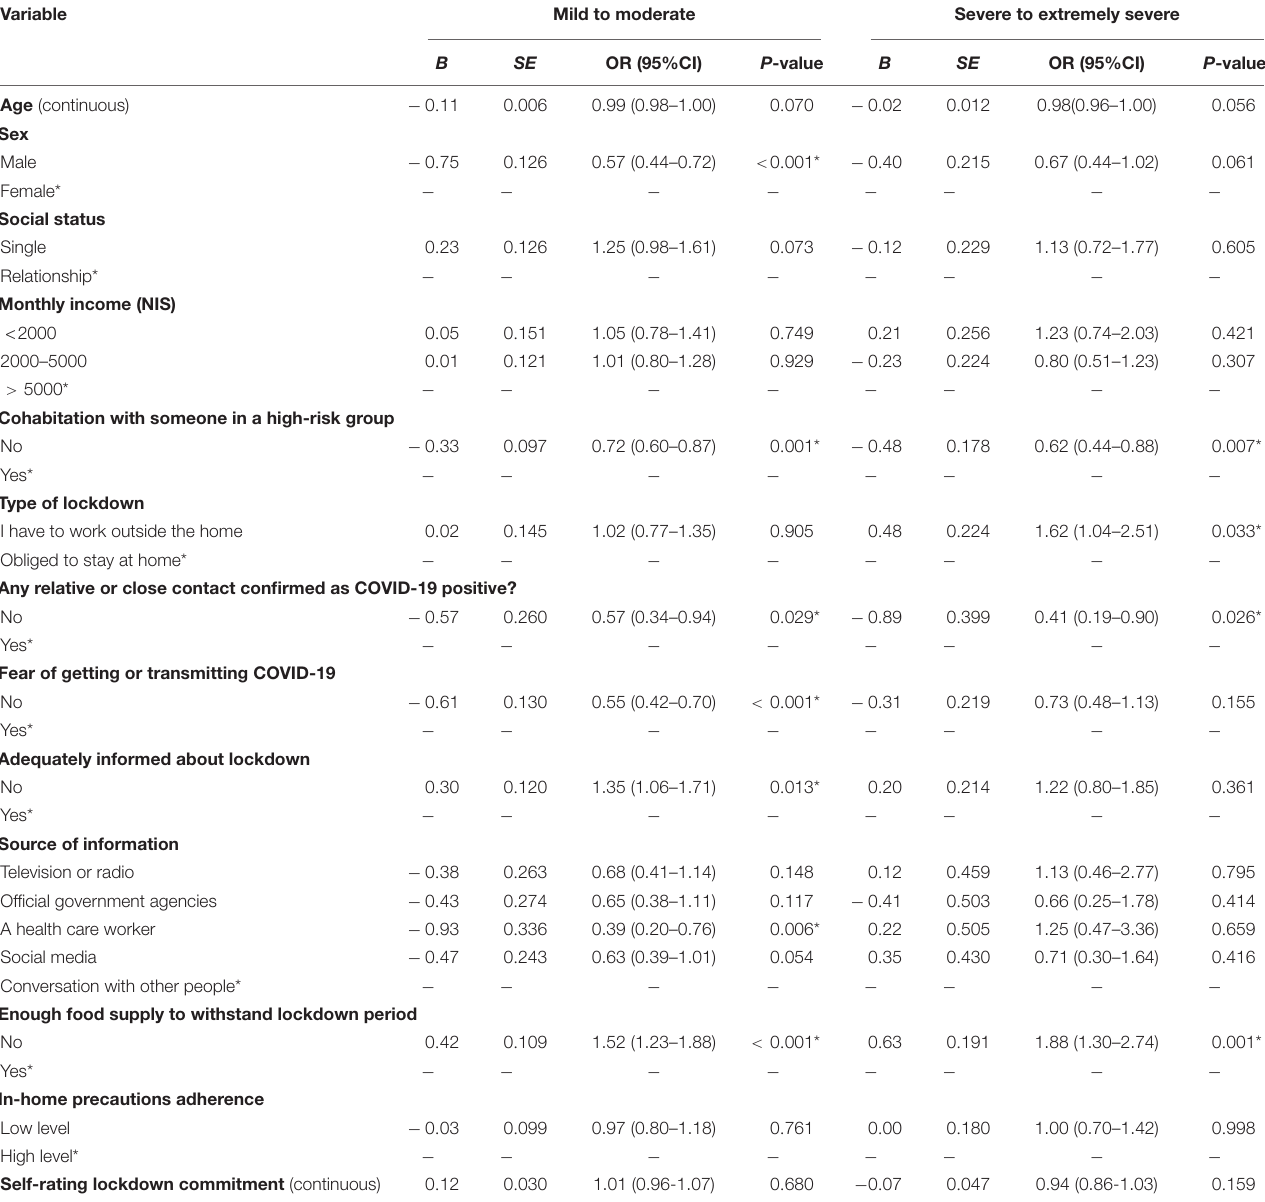
TABLE 3 | Multinomial regression model for the variables associated with anxiety severity # ( N = 2819). Variable Mild to